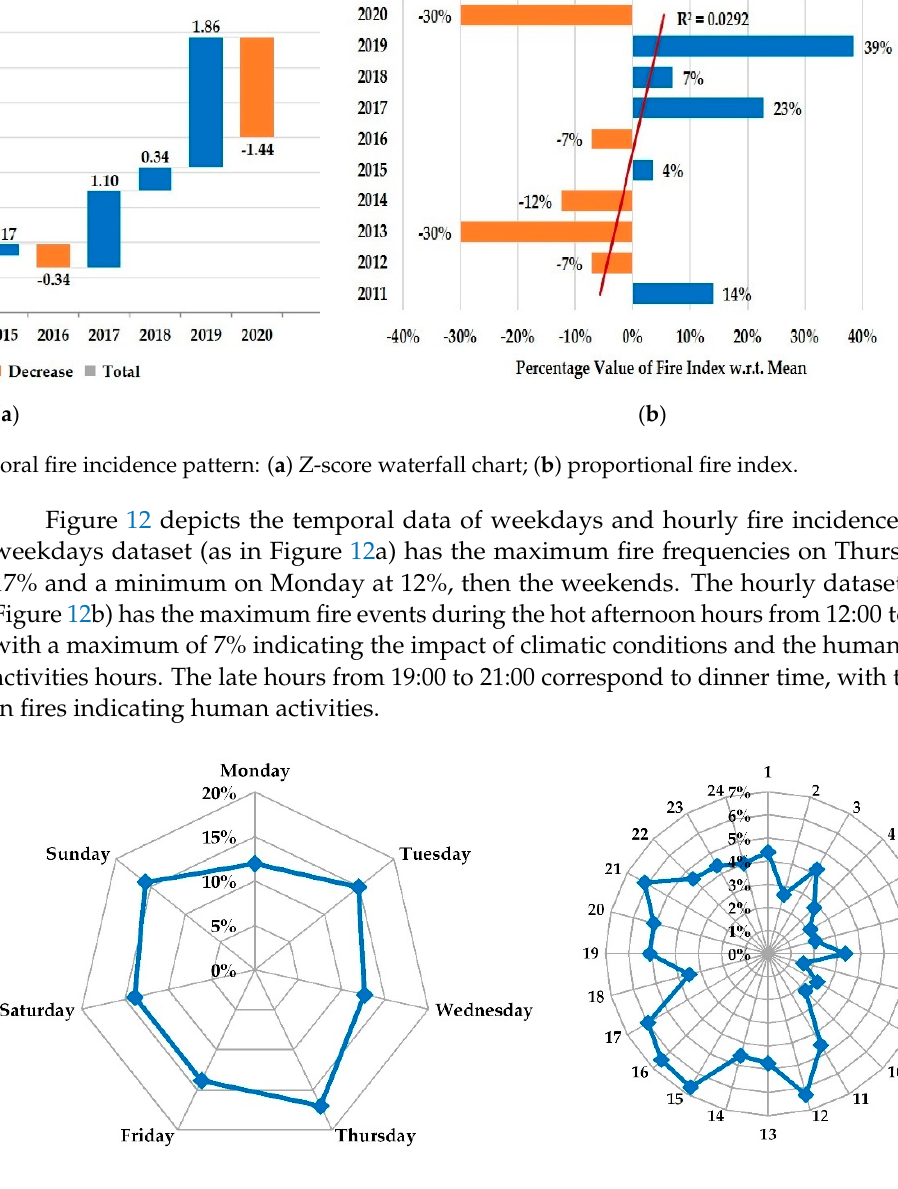
Figure 10. Yearly fire incidences, UN population, and ratio.